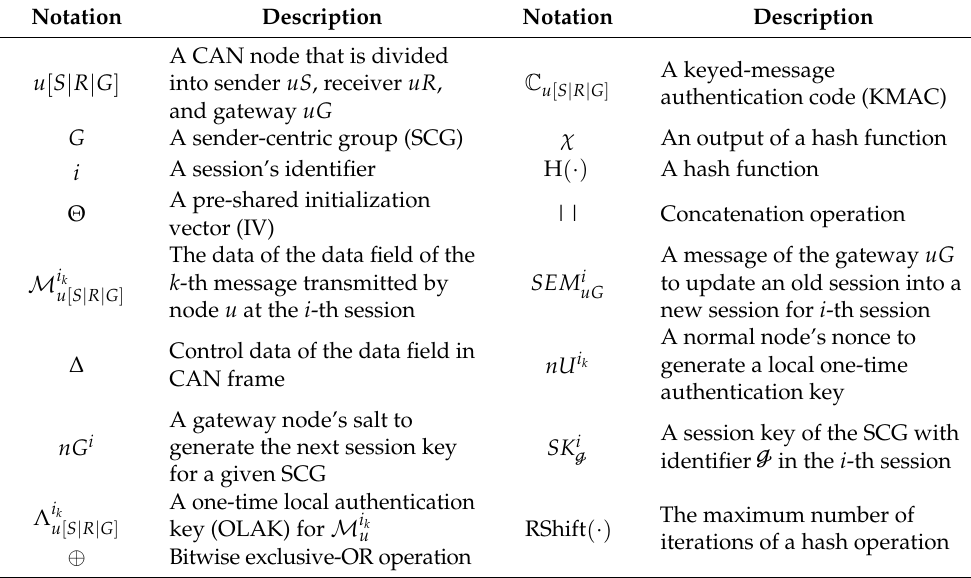
Table 1. Summary of notations used for